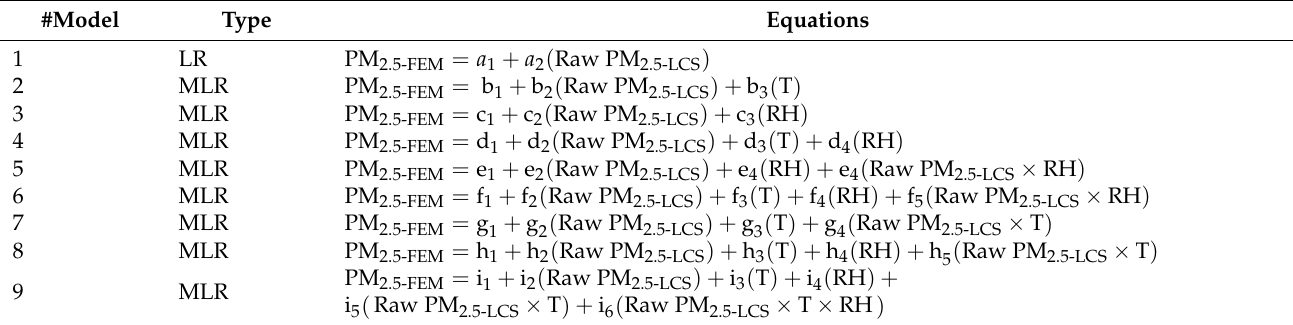
Table 2. Developed calibration models by LR and MLR to improve LCS